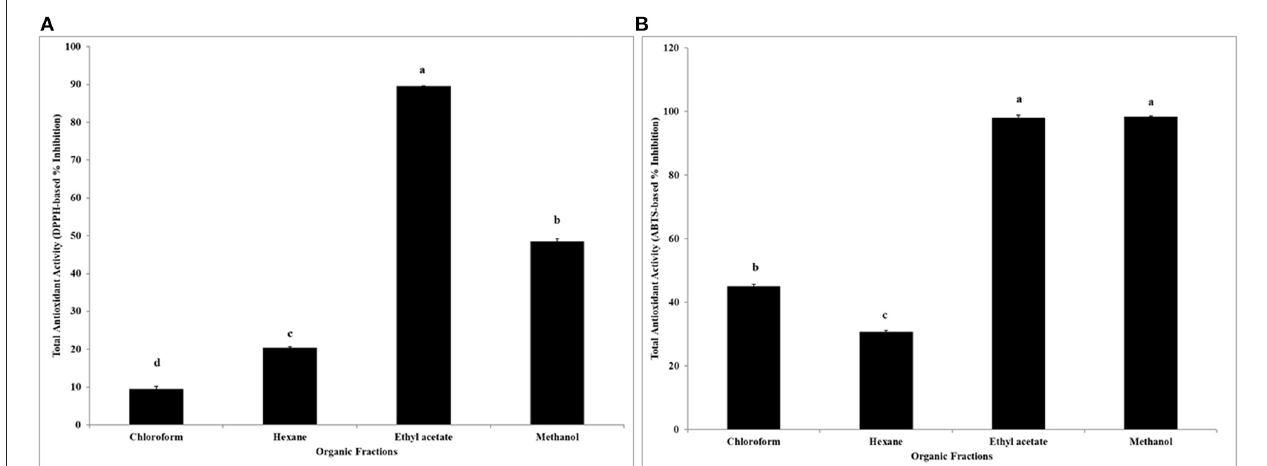
FIGURE 4 | Total antioxidant activity (% inhibition) of four organic solvent extracted fractions of red dried calyces of Roselle based on DPPH (A) and ABTS (B) free radical scavenging assays. Different lower-case letters represent statistically significant differences in total antioxidant activity between different organic solvent